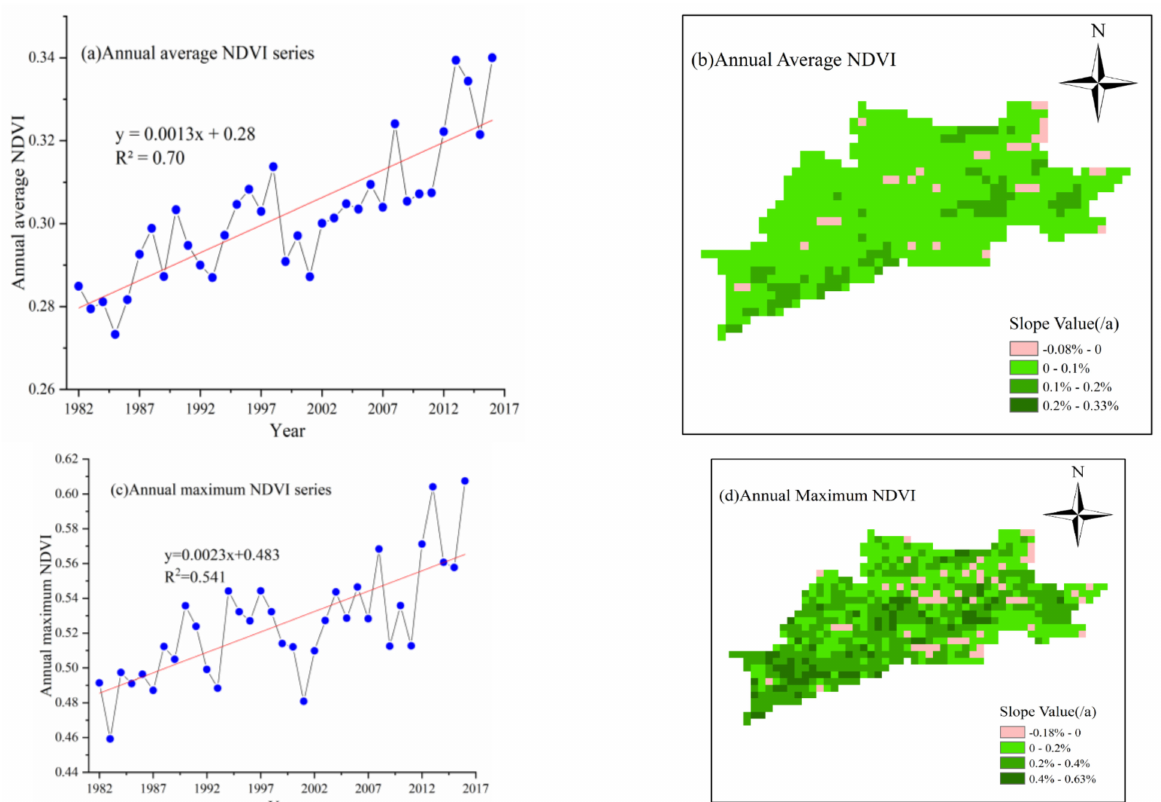
Figure 8. Annual average and annual maximum NDVI variation characteristics in the mountain area of Yongding River from 1982 to 2015. ( a ) the annual average NDVI in the YRMA from 1982 to 2015; ( b ) the space distribution of the slope value of the annual average NDVI in the YRMA from 1982 to 2015; ( c ) annual maximum NDVI in the YRMA from 1982 to 2015; ( d ) the space distribution of the slope value of the annual average NDVI in the YRMA from 1982 to